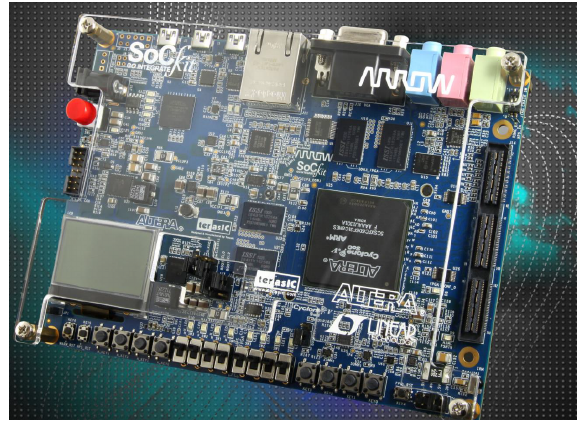
Figure 2. Terasic system on a chip (SoC) kit development board.